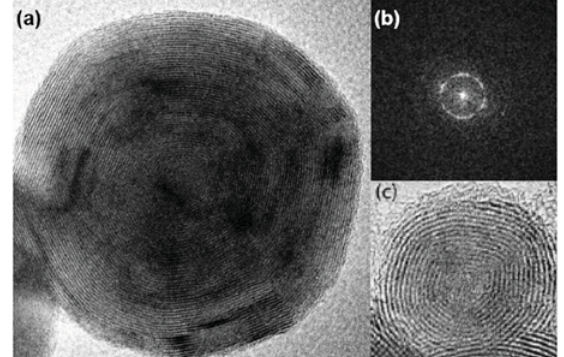
nanotubes obtained in the reaction between WCl 2